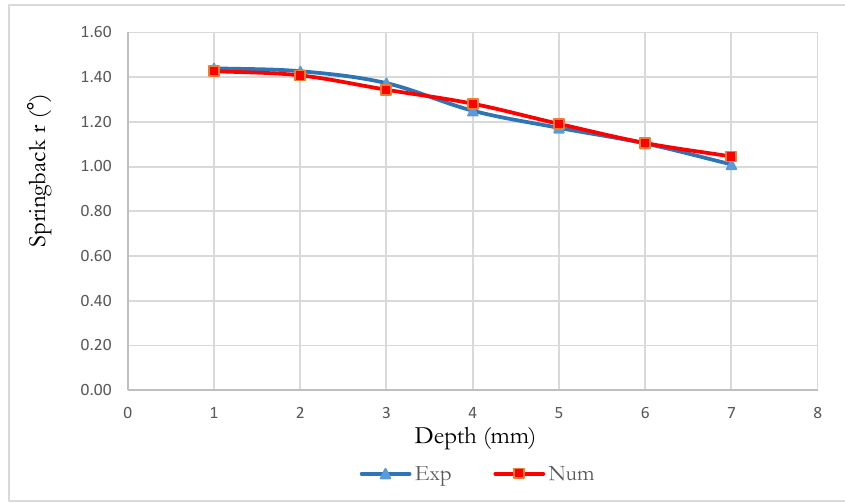
Fig. 12. Comparison of the results for the thickness of 2